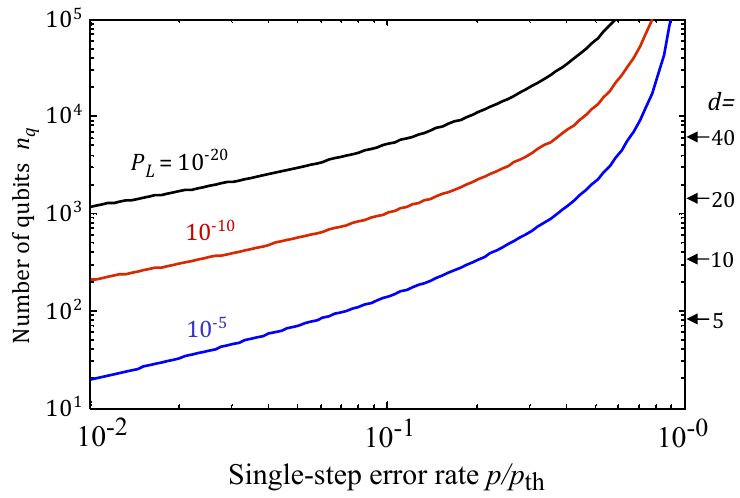
Figure 24: Estimated number of physical qubits n step error rate p , normalized to the threshold error rate p error rates P . Figure from Ref. (Fowler, Mariantoni, Martinis and Cleland, L